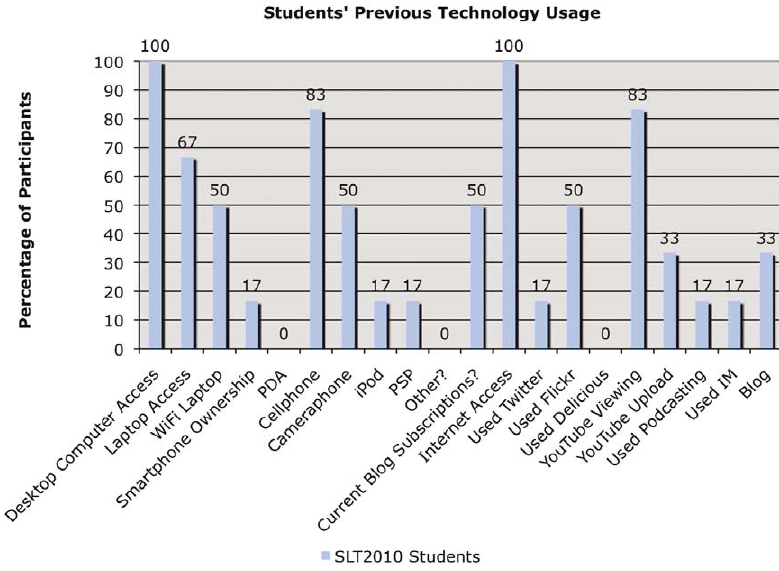
Figure 2. SLT students’ previous technology